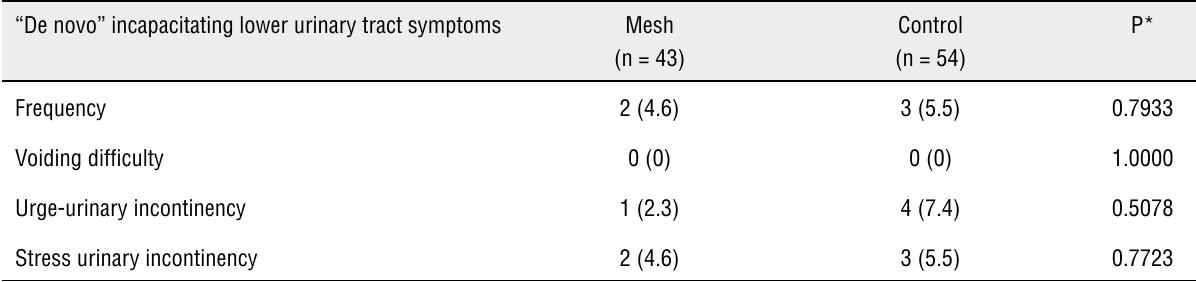
Table 5 – Surgery effect on “de novo” lower urinary tract symptoms after 12-month follow-up, in Mesh and Control groups. Values expressed in frequency and percentage (%).